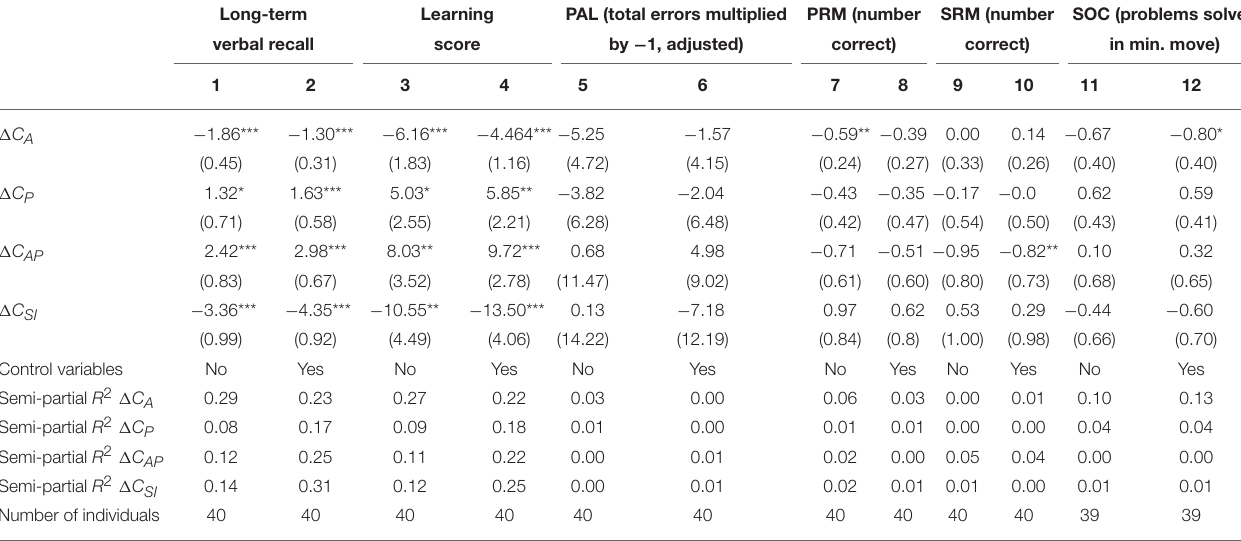
TABLE 2 | Linear regression of the memory capacity and coherence for the four main regions of